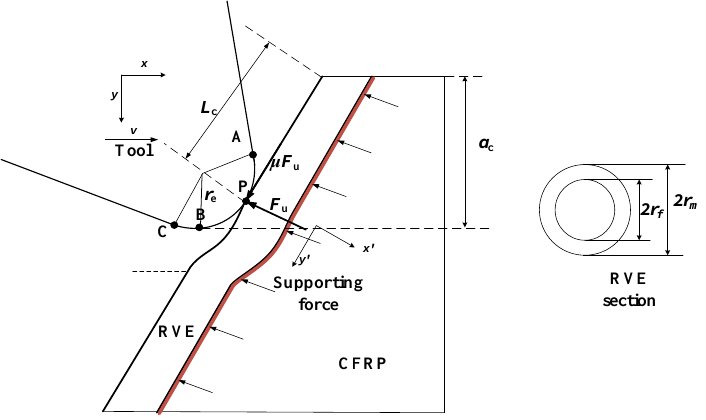
Figure 10. Schematic diagram of the forces acting on the RVE. The cutting tool exerts the force F u on the RVE, as well as the supporting material on the opposite side.